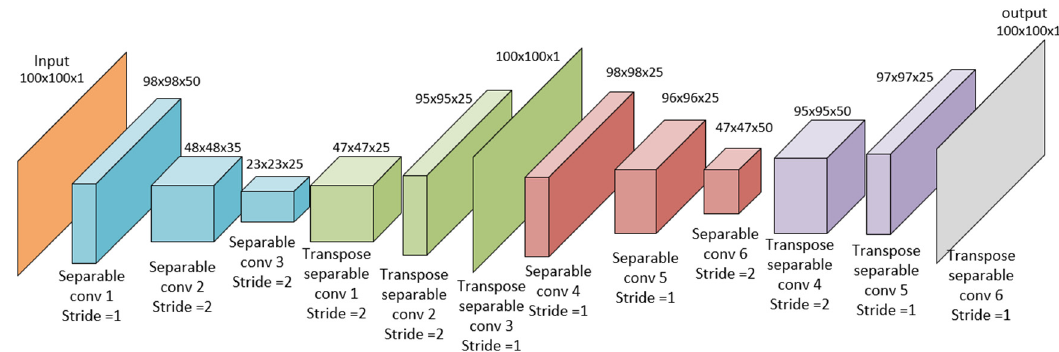
Figure 4. The neural architecture of the dual autoencoder.